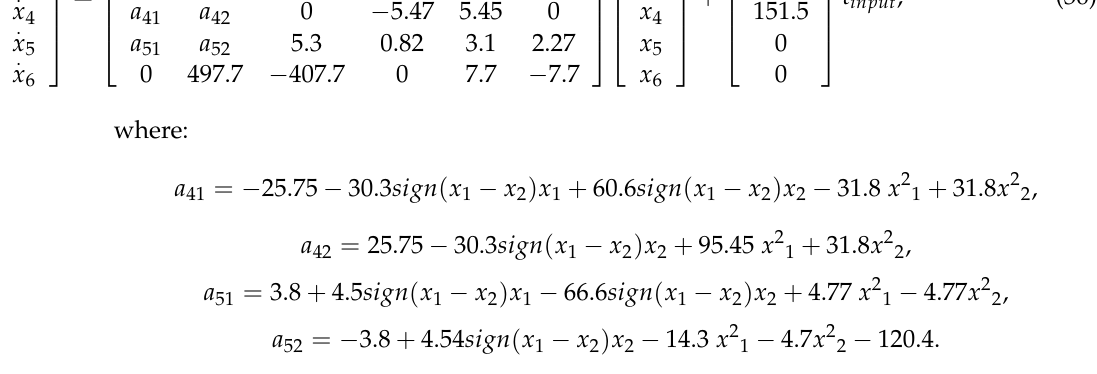
Table 3. Suggested NRA parameters [34].